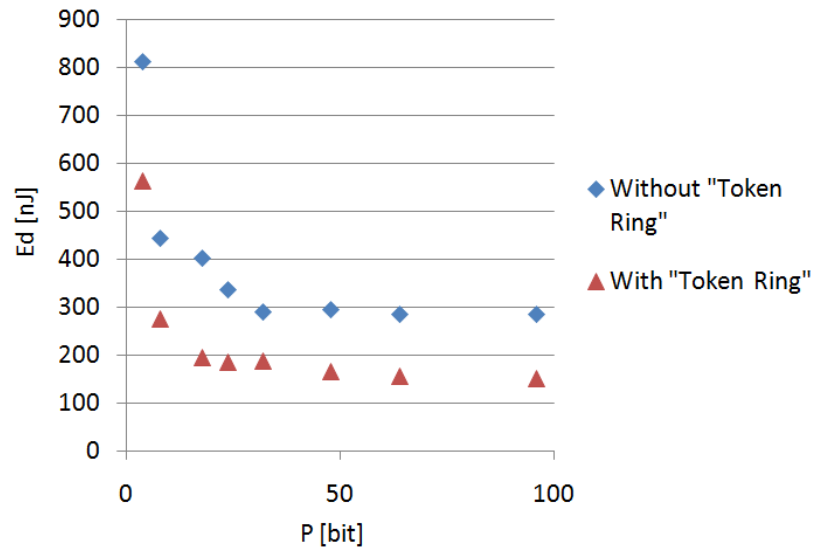
Figure 8. Influence of the P value on the E d value for a QC-LDPC decoder with an architecture based